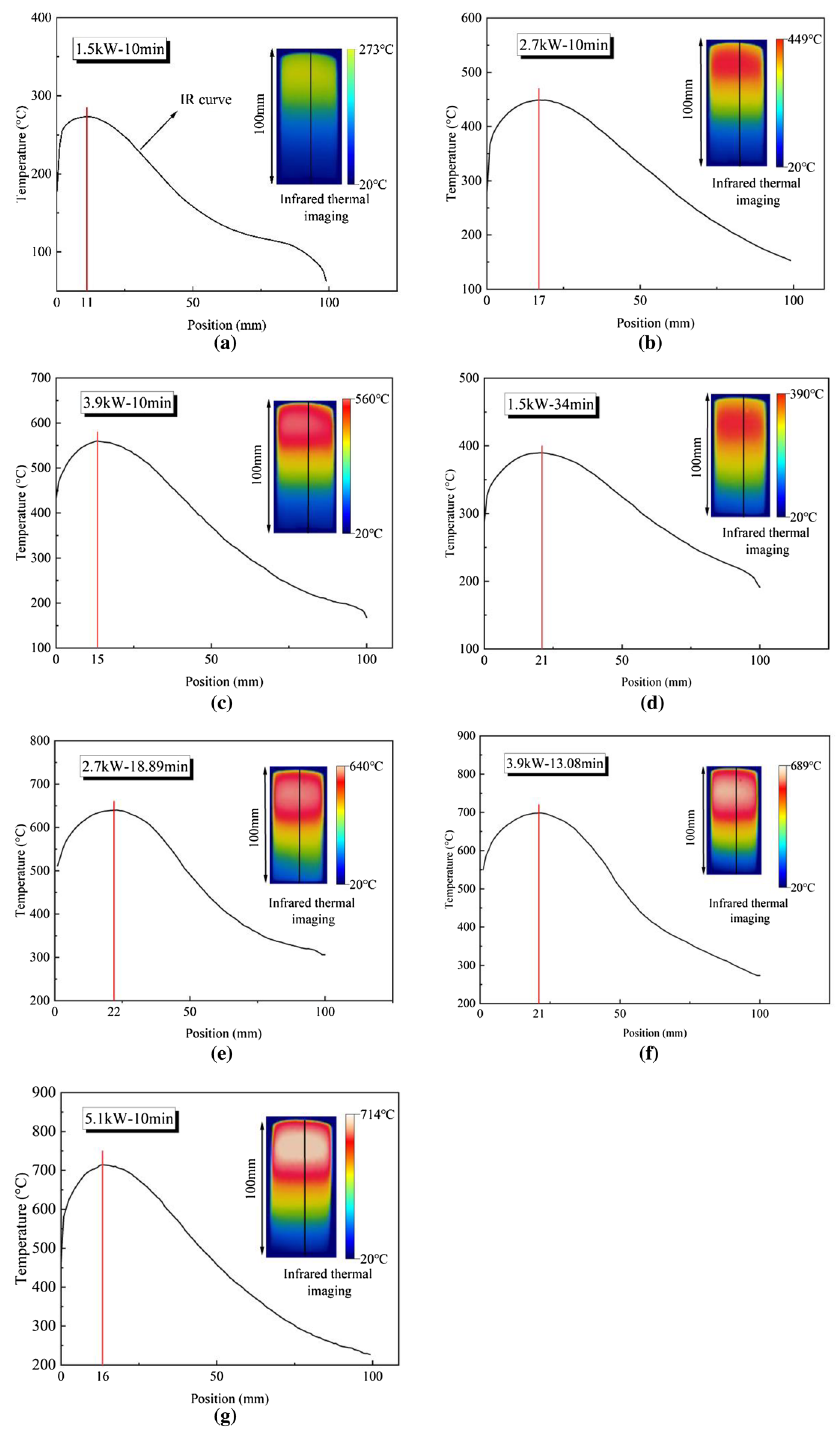
Figure 5. Temperature distribution along the vertical axis of specimens heated for basalt (red solid line represents the maximum temperature): ( a ) at 1.5kW for 10 min; ( b ) at 2.7kW for 10 min; ( c ) at 3.9 kW for 10 min; ( d ) at 1.5kW for 34 min; ( e ) at 2.7 kW for 18.88 min; ( f ) at 3.9 kW for 13.08 min; ( g ) at 5.1 kW for 10